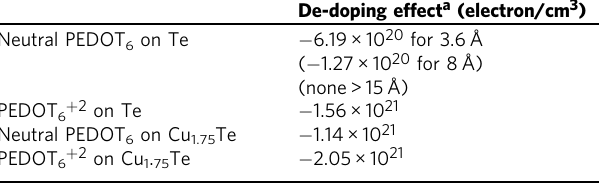
De-doping level of neutral and doped PEDOT hexamer by Te and Cu 1.75 Te surfaces for the optimized